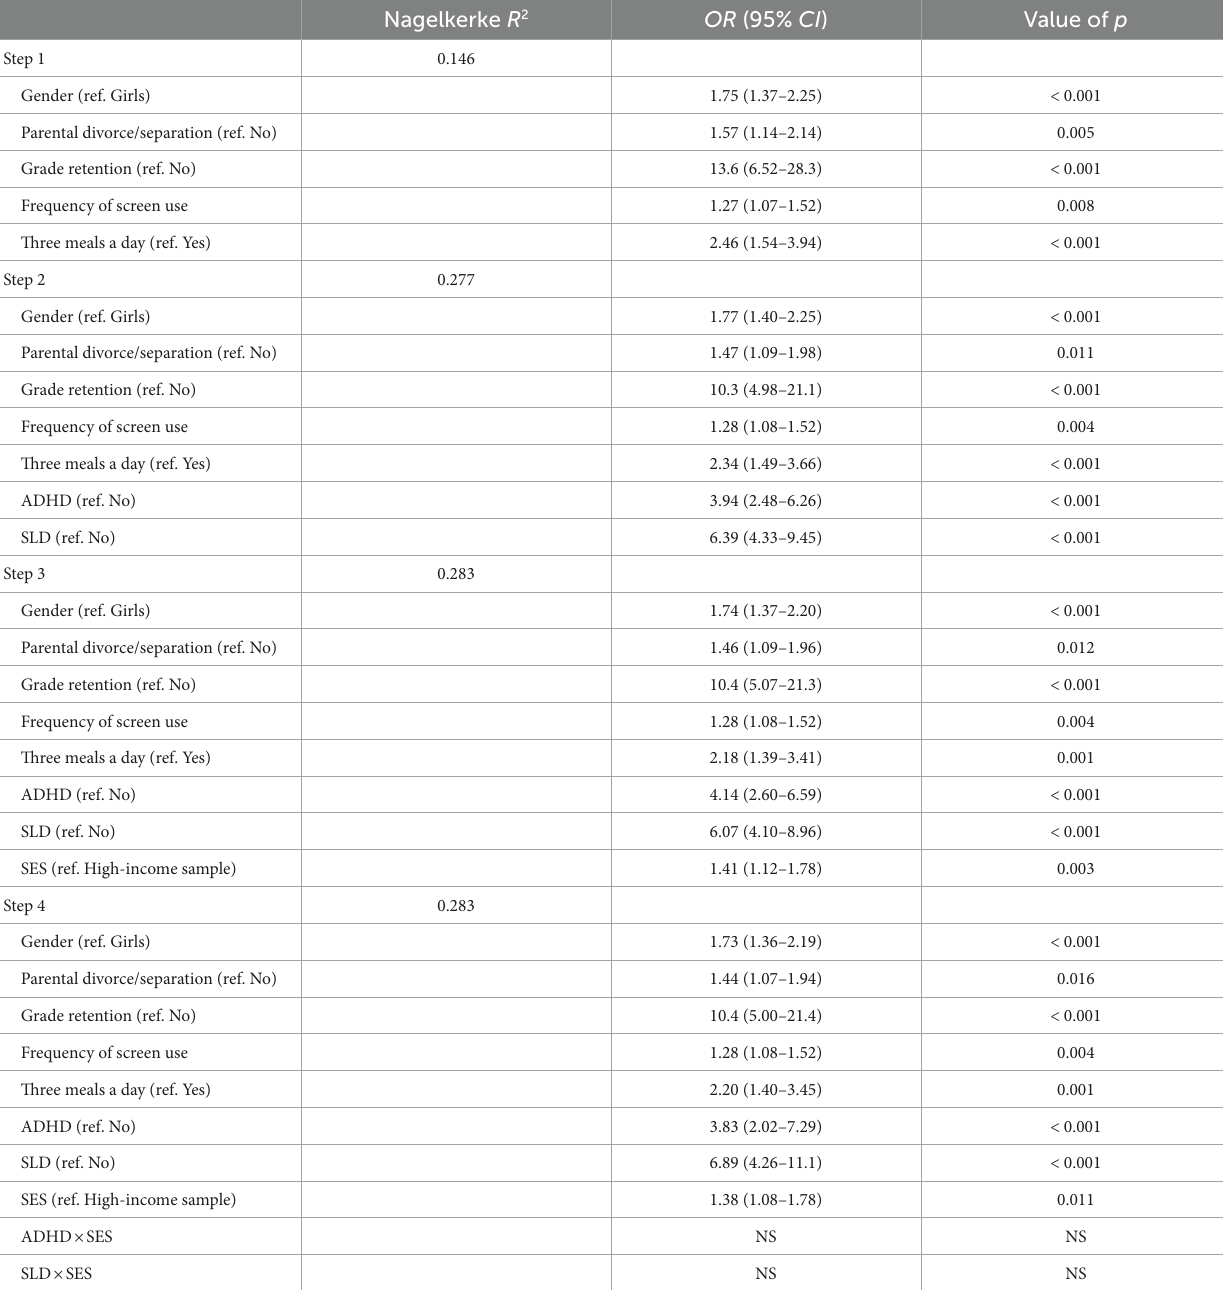
TABLE 4 Predictors of poor academic performance on first